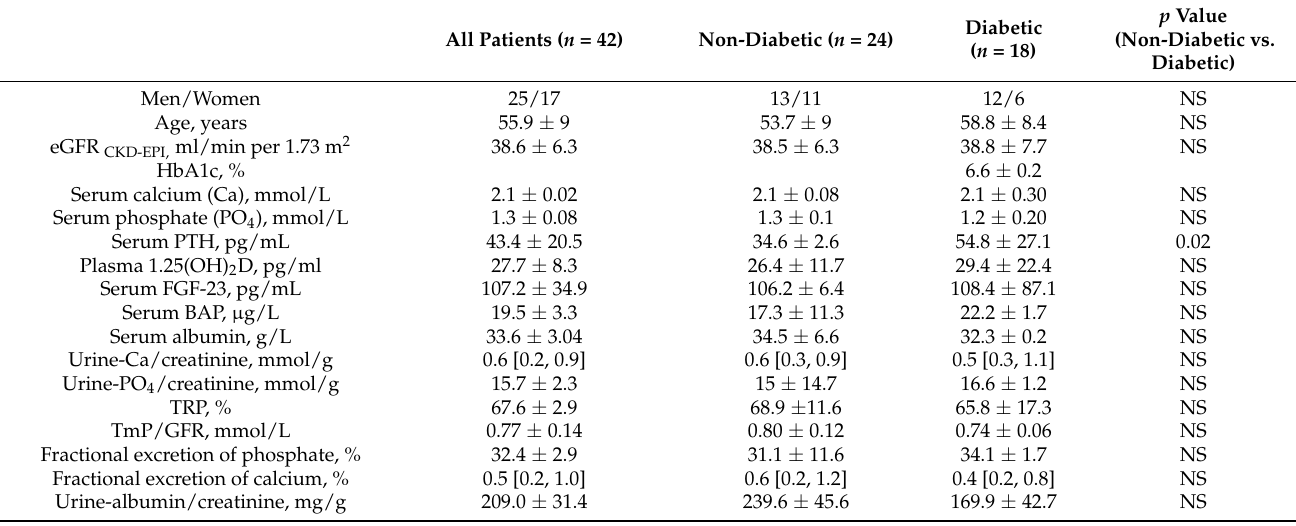
All Patients ( n = 42) Non-Diabetic ( n = 24)